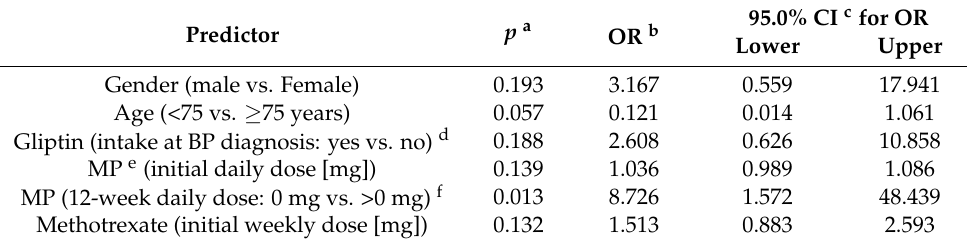
Table 6. Cox proportional hazards model of suffering at least one feasibility-limiting event (relapse or severe adverse event, the one that occurred first). Overall, 13/44 patients with a follow-up time ≥ 6 months developed a feasibility-limiting event.